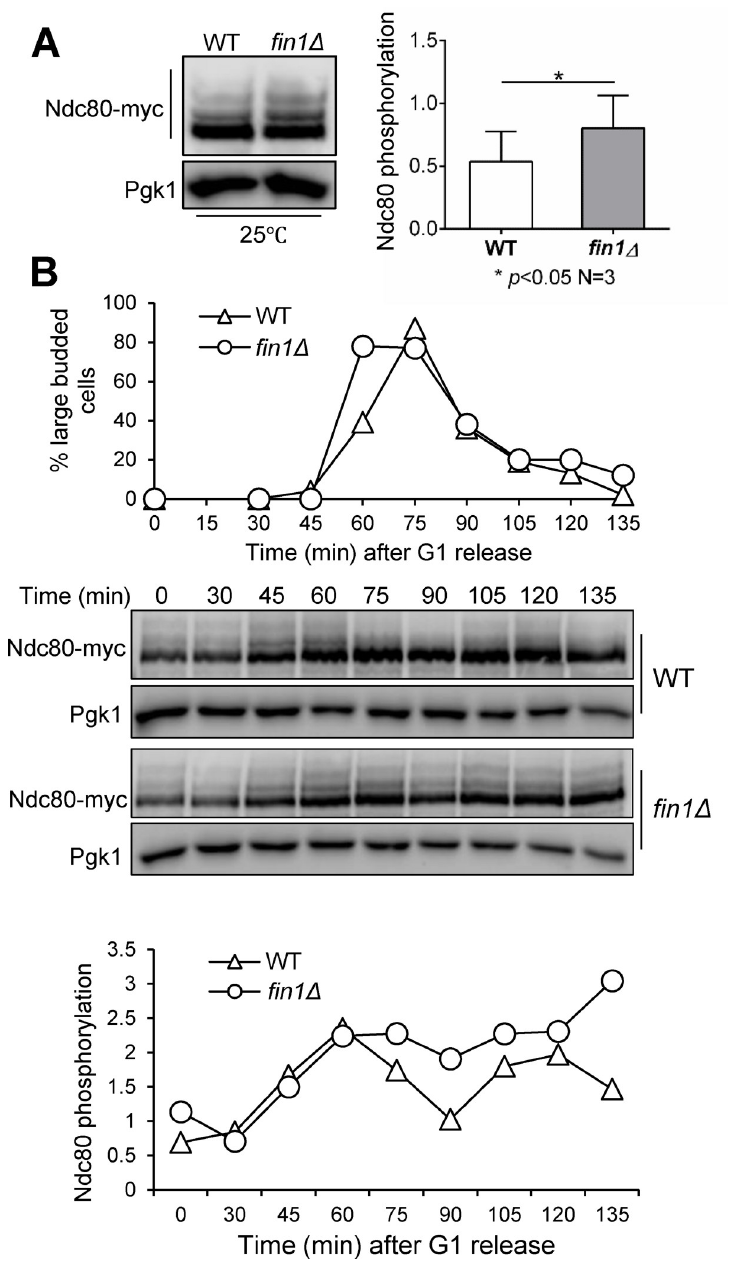
Fig 5. Fin1-PP1 promotes dephosphorylation of Ipl1 substrate Ndc80 in anaphase. (A) Analysis of Ndc80 phosphorylation in WT (3802-1-4) and fin1 Δ (3802-2-2) cells using Phos-tag gel. WT and fin1 Δ cells with Ndc80- 13myc were grown to log phase in YPD at 30˚C. Protein samples were collected and separated on Phos-tag gel. The membrane was probed with anti-myc antibody to show separation of phosphorylated Ndc80 species. The image shown is a representative of three experimental repeats and statistical significance determined by p < 0.05 using Wilcoxon rank sum test. (B) fin1 Δ cells show delayed Ndc80 dephosphorylation. WT (3802-1-4) and fin1 Δ (3802-2-2) cells containing Ndc80-13myc were arrested in G 1 and then released into YPD at 30˚C. Cells were collected every 15 minutes to prepare protein samples and count budding index. Phos-tag gel was used for protein separation and show phosphorylated Ndc80 protein species. The ratio of phosphorylated species to Pgk1 loading control was quantified using ImageJ for each time point and graphed. Pictures are representative from three experimental repeats.